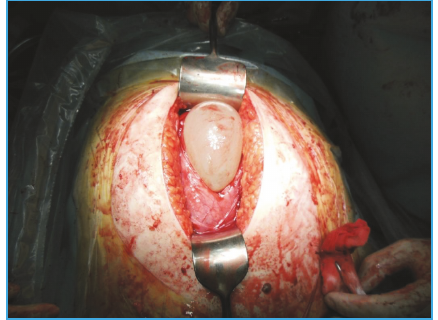
Figure 2: The uterus is cut vertically.